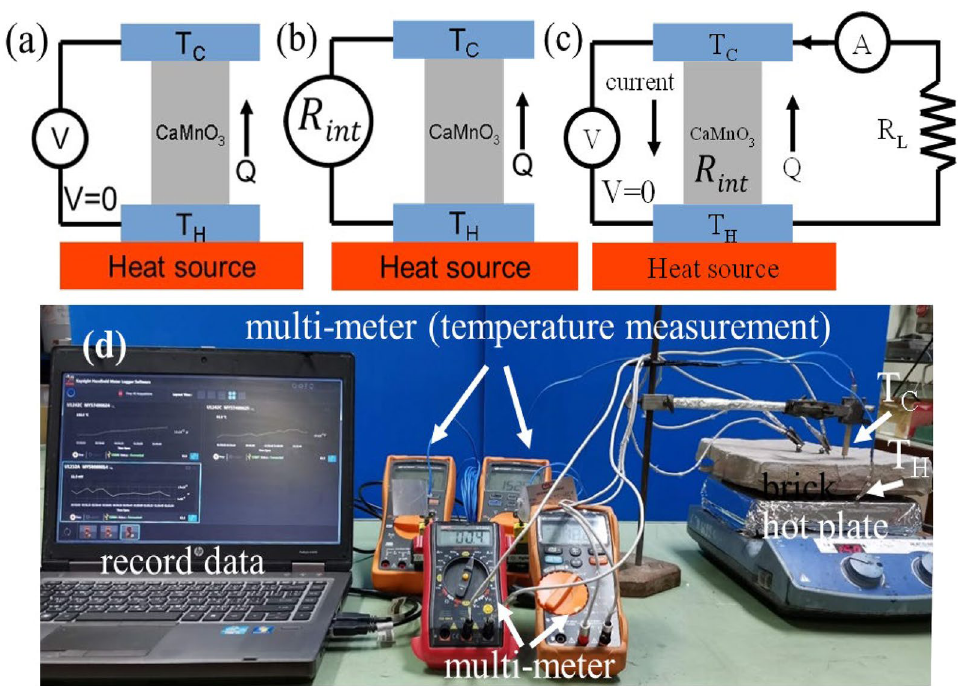
Figure 9. ( a , b ) Schematic diagram of open circuit measurement of the TEG module, ( c ) Schematic diagram of closed-circuit measurement of the TEG module, ( d ) Experimental setup of the thermoelectric concrete brick (I-layer and III-layer brick